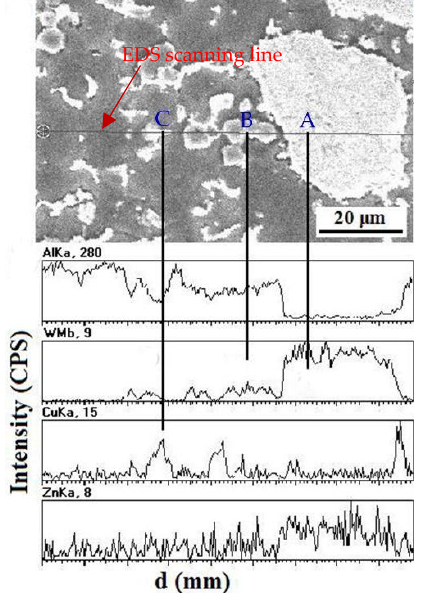
Figure 8. Energy dispersive spectrometer (EDS) results of line scanning in the local zone of Figure 7b.